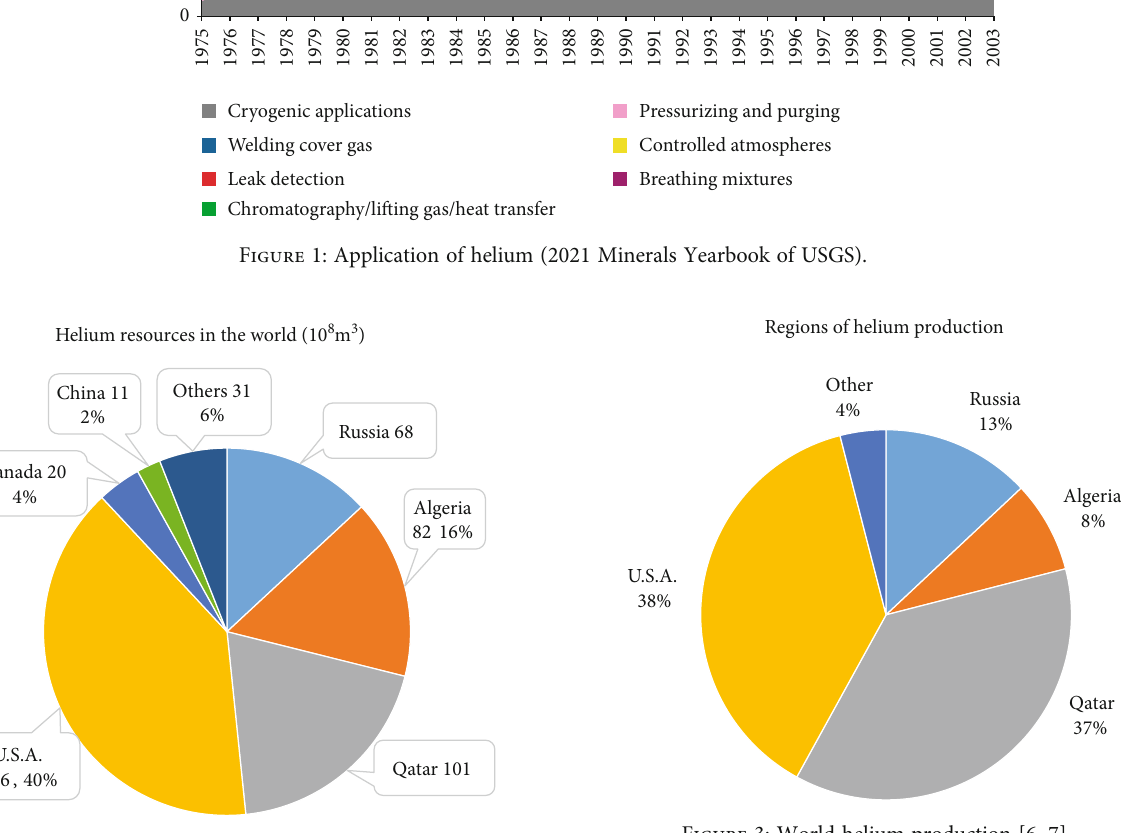
Figure 2: World helium resources [6].